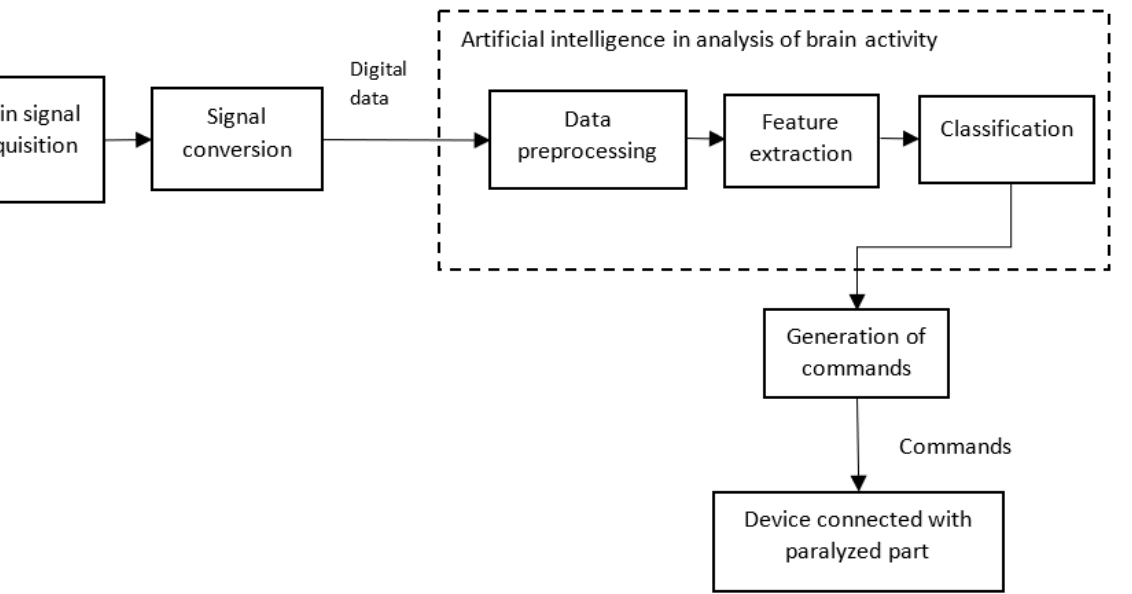
Figure 8. AI for the analysis of neural activity captured through a BCI for the movement of a para- lyzed